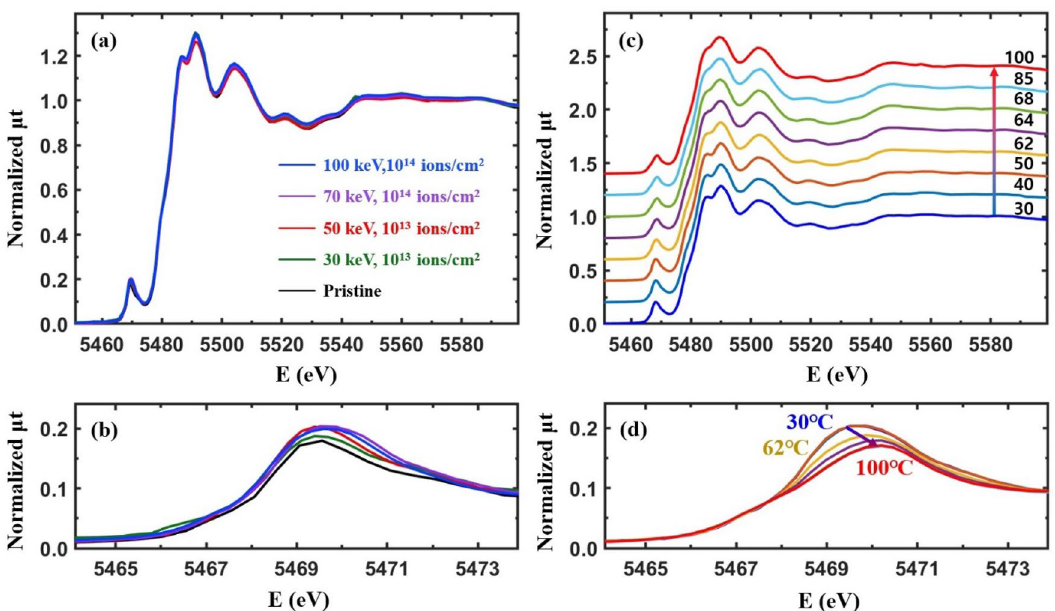
Figure 6. ( a ) Normalized total X-ray absorption (μt) for Co-VO 2 films with different Co ion energies and fluxes at the V K edge as a function of the incident X-ray energy at room temperature. The films are the same as those in Fig. 2. ( c ) Temperature-dependent XANES for Co-VO 2 with a Co energy of 70 keV and a flux of 10 14 ions/ cm 2 . ( b , d ) are the magnified images of the pre-edge peaks in ( a , c ), respectively. Data in ( c ) are vertically shifted for